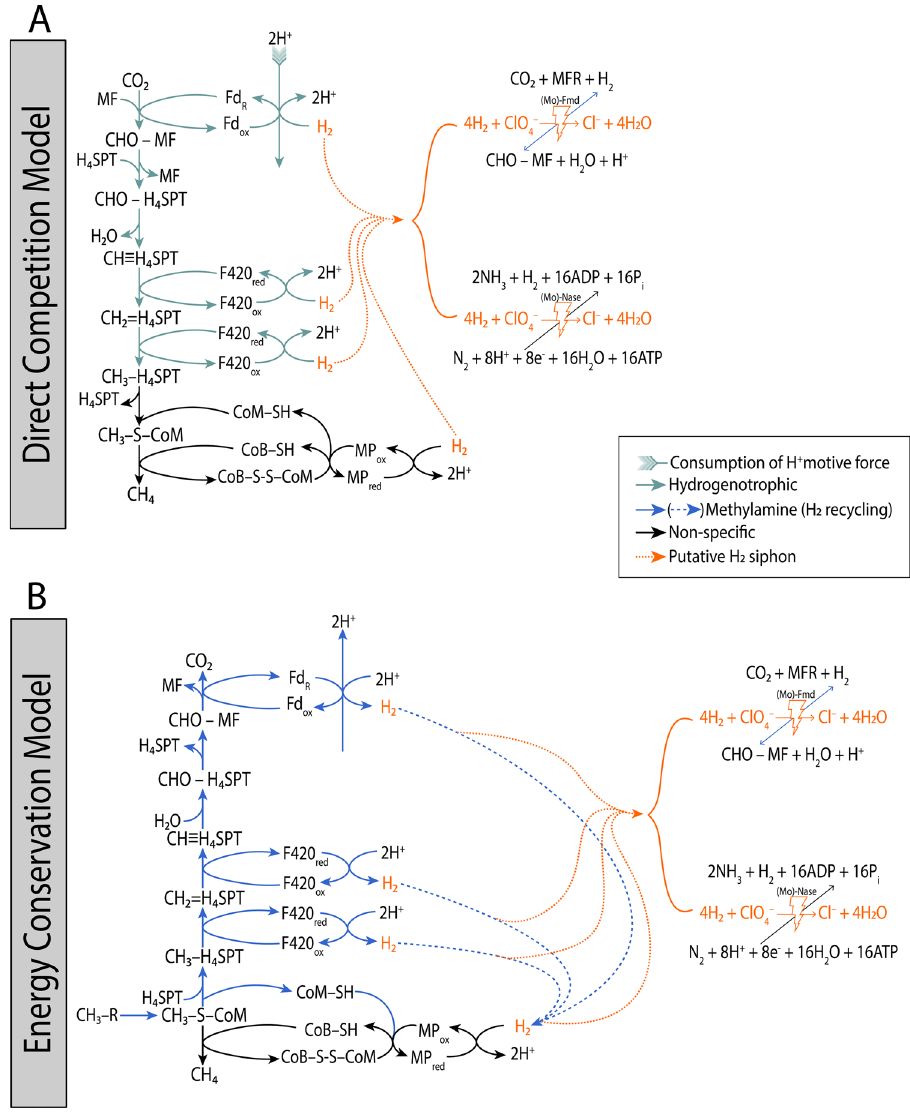
Figure 6. Proposed models of Mo- and H 2 -dependent perchlorate reduction occurring ( a ) in direct competition with hydrogenotrophic methanogenesis, and ( b ) via the energy-conserving partial reversal of methylamine-based methanogenesis. Abbreviations: Non-specific, common to multiple pathways; MF, methanofuran; CHO-MF, formyl-methanofuran; H 4 SPT, tetrahydrosarcinapterin; CHO-H 4 SPT, formyl-tetrahydrosarcinapterin; CH ≡ H 4 SPT, methenyl-tetrahydrosarcinapterin; CH 2 = H 4 SPT, methylene- tetrahydrosarcinapterin; CH 3 -H 4 SPT, methyl-tetrahydrosarcinapterin; CoM-SH, coenzyme M; CoB-SH, coenzyme B; CoB-S–S-CoM, CoB-CoM heterodisulphide; CH 3 -S-CoM, methyl-coenzyme M; CH 3 - R, methylamine; MP, methanophenazine; Fd, ferredoxin; F420, coenzyme F420; (Mo)-Fmd, (Mo)- formylmethanofuran dehydrogenase; (Mo)-Nase,